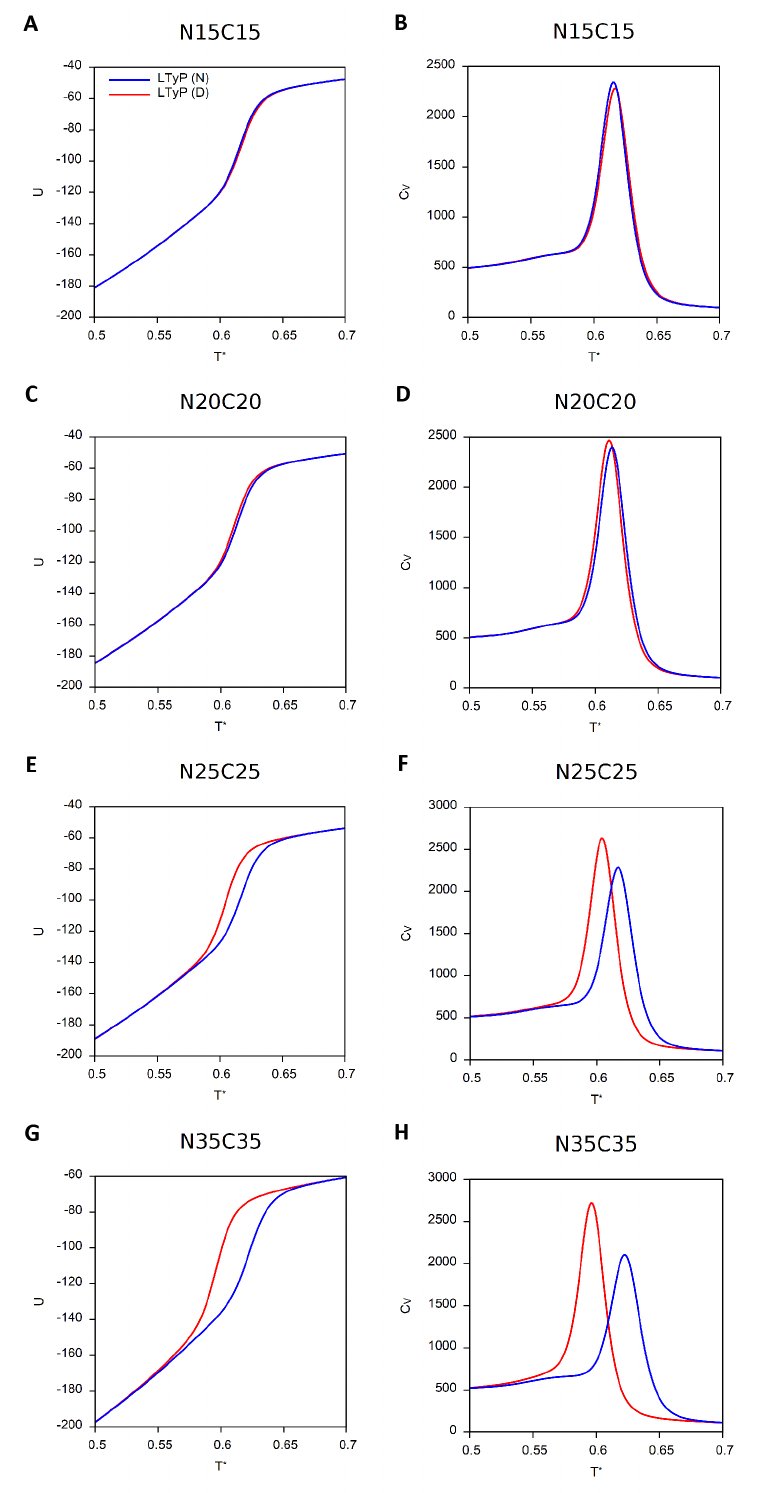
Figure 6. Internal energy, U , and heat capacity, C V , as functions of reduced temperature for MJ0366 with tails of increasing length. Simulations starting from native conformation (N) are colored blue and those starting from a denatured conformation (D) are colored red. ( A , B ) N15C15. ( C , D ) N20C20. ( E , F ) N25C25. ( G , H )